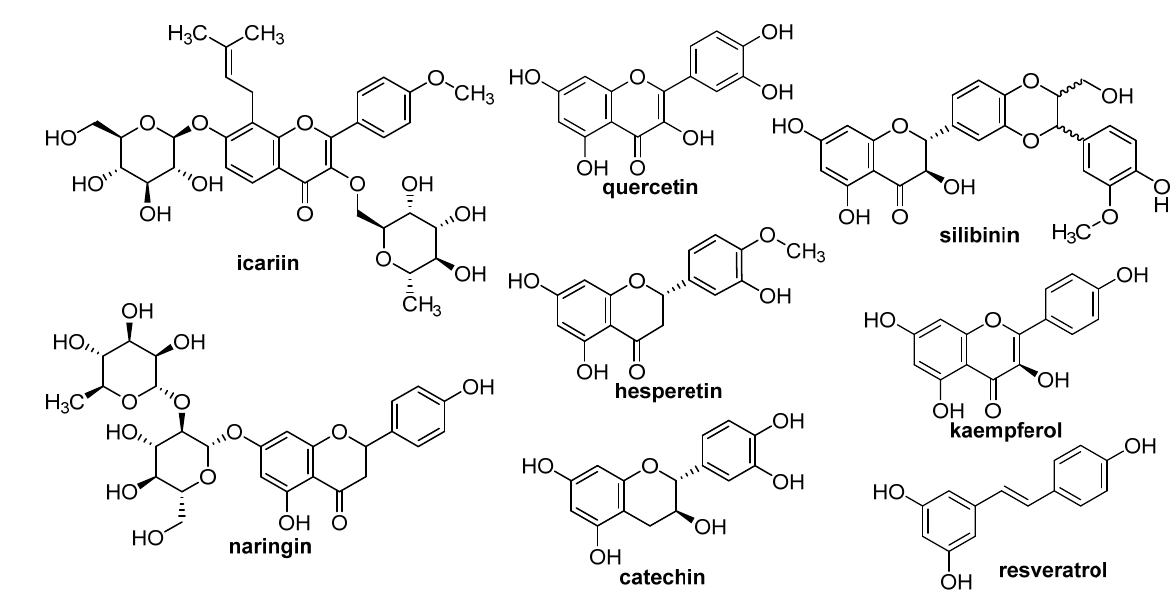
Figure 11. Chemical structure of discussed flavonoid-based compounds.